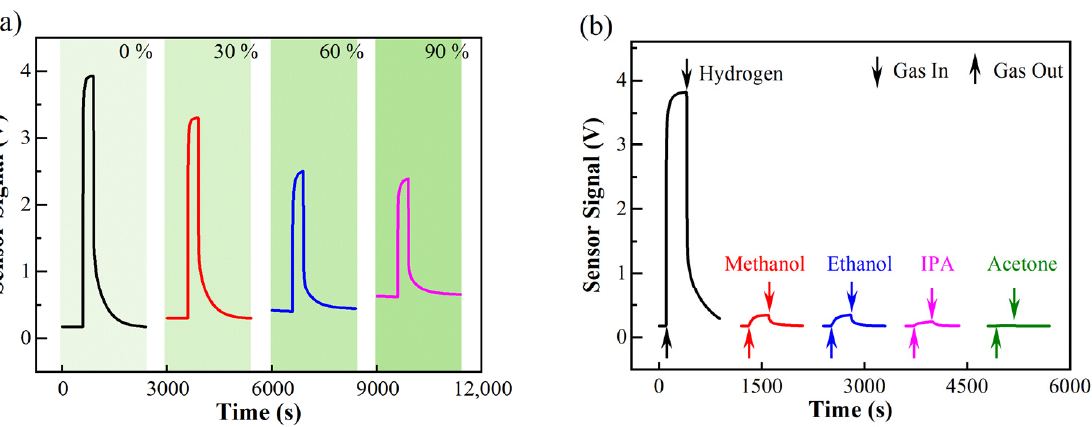
Figure 5. ( a ) Humidity dependance of the sensing response of Winsen MQ-8 sensor for 1000 ppm hydrogen. ( b ) Selectivity test of Winsen MQ-8 sensor measured against 200 ppm methanol, ethanol, isopropanol (IPA), and acetone. Both the heating voltage and the applied voltage for signal meas- urement are 5 V, corresponding to a working temperature ~250 °C.